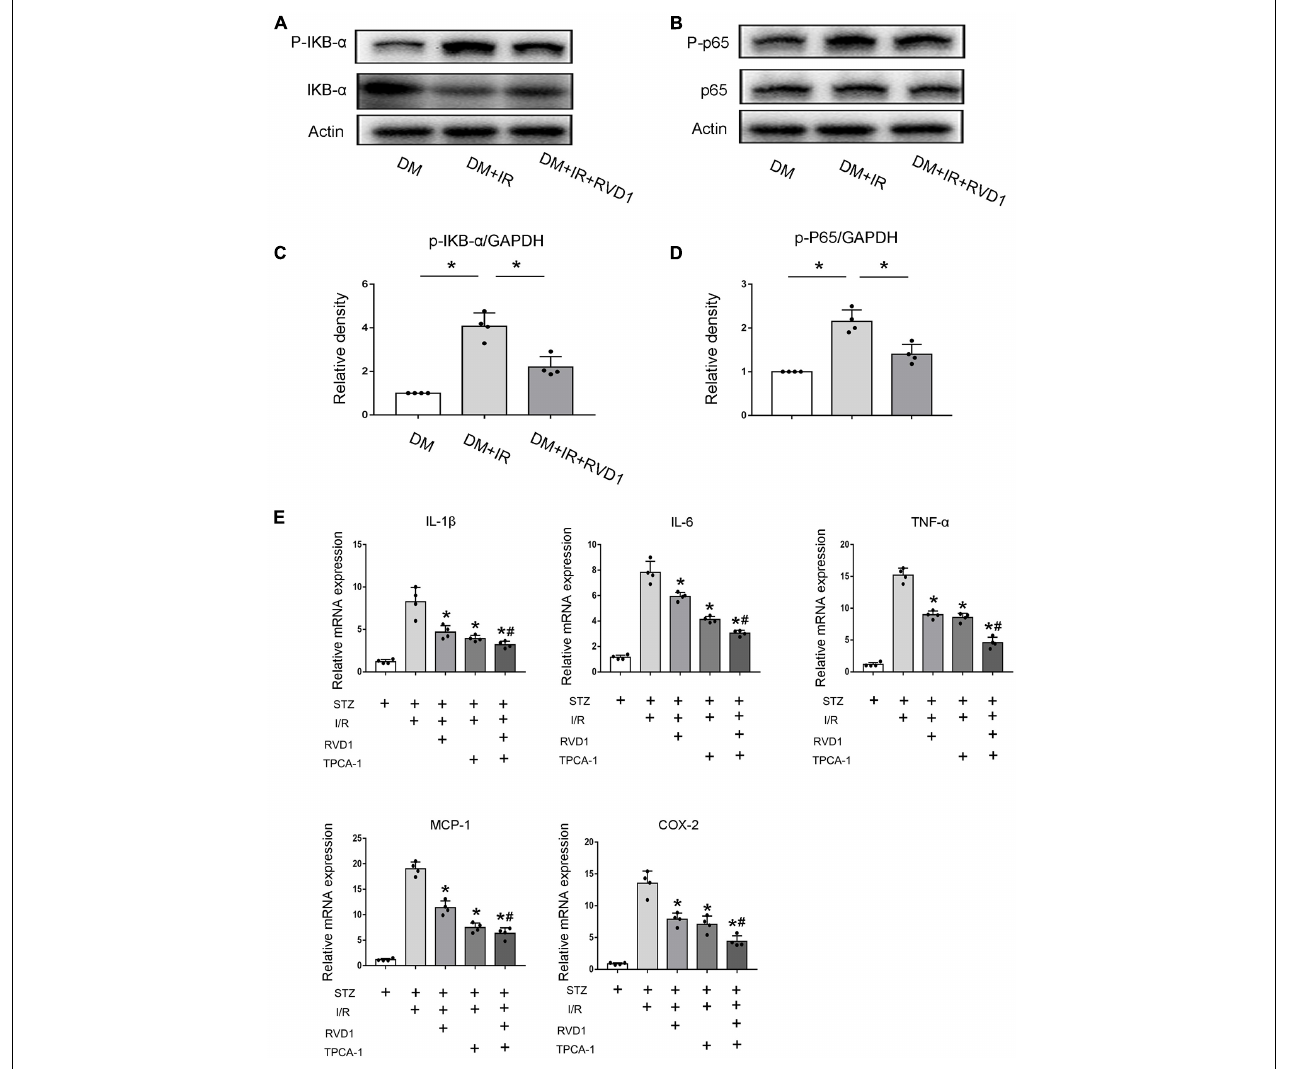
FIGURE 5 | Resolvin D1 (RvD1) inhibits NF- κ B activation after ischemic injury in streptozotocin (STZ)-induced diabetic mice. Male C57BL/6J mice were injected with STZ or vehicle solution to induce diabetic mice (DM) or non-diabetic mice (ND). The mice were then subjected to sham operation or 30 min of bilateral renal ischemia followed by 48 h of reperfusion (I/R48). For some groups, RvD1 (50 µ g/kg) or TPCA-1 (5 mg/kg) was injected intraperitoneally 30 min before renal ischemia–reperfusion. Renal tissues were collected at 48 h of reperfusion for further analysis. (A,B) Immunoblot analysis for IKB α , p-IKB α , p65, and P-p65. GAPDH was used as the internal control. (C,D) Densitometry analysis of the p-p65 and p-I κ B- α levels in kidney tissues. Data are shown as the mean ± SD ( n = 4). * p < 0.05. (E) Real-time PCR for IL-1, IL-6, cTNF- α , MCP-1, and COX-2. Data are shown as the mean ± SD ( n = 4). * p < 0.05 vs. the relevant STZ + I/R group; # p < 0.05 vs. the relevant STZ + I/R + RvD1